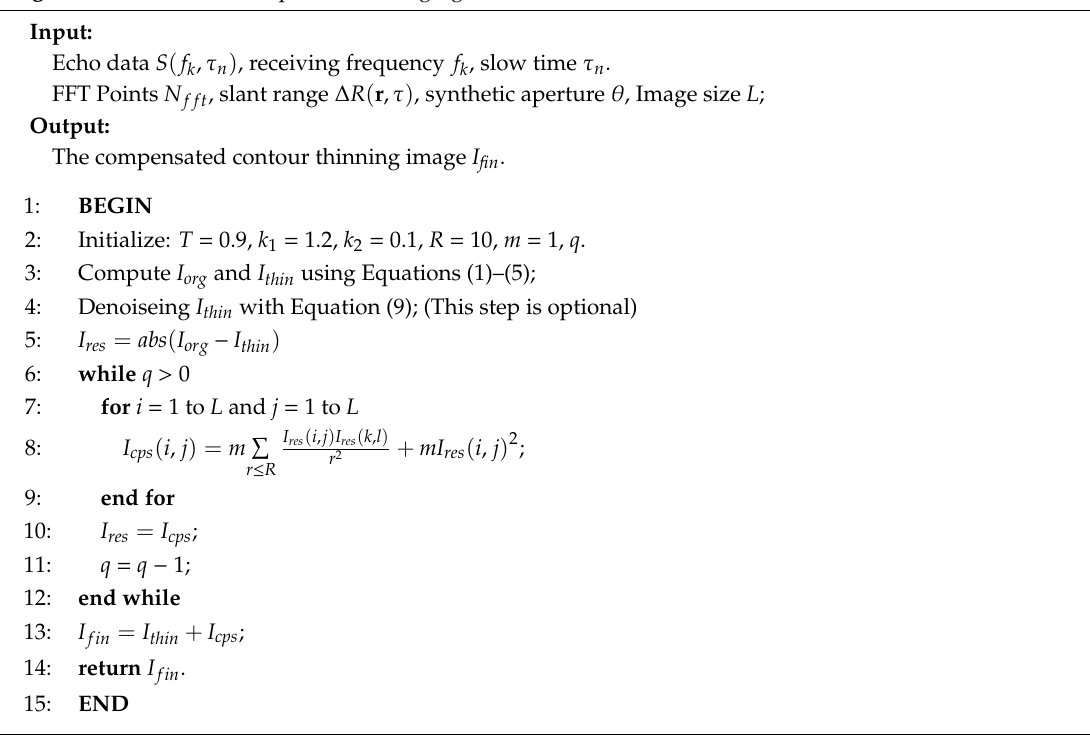
Algorithm 1: Residual compensation